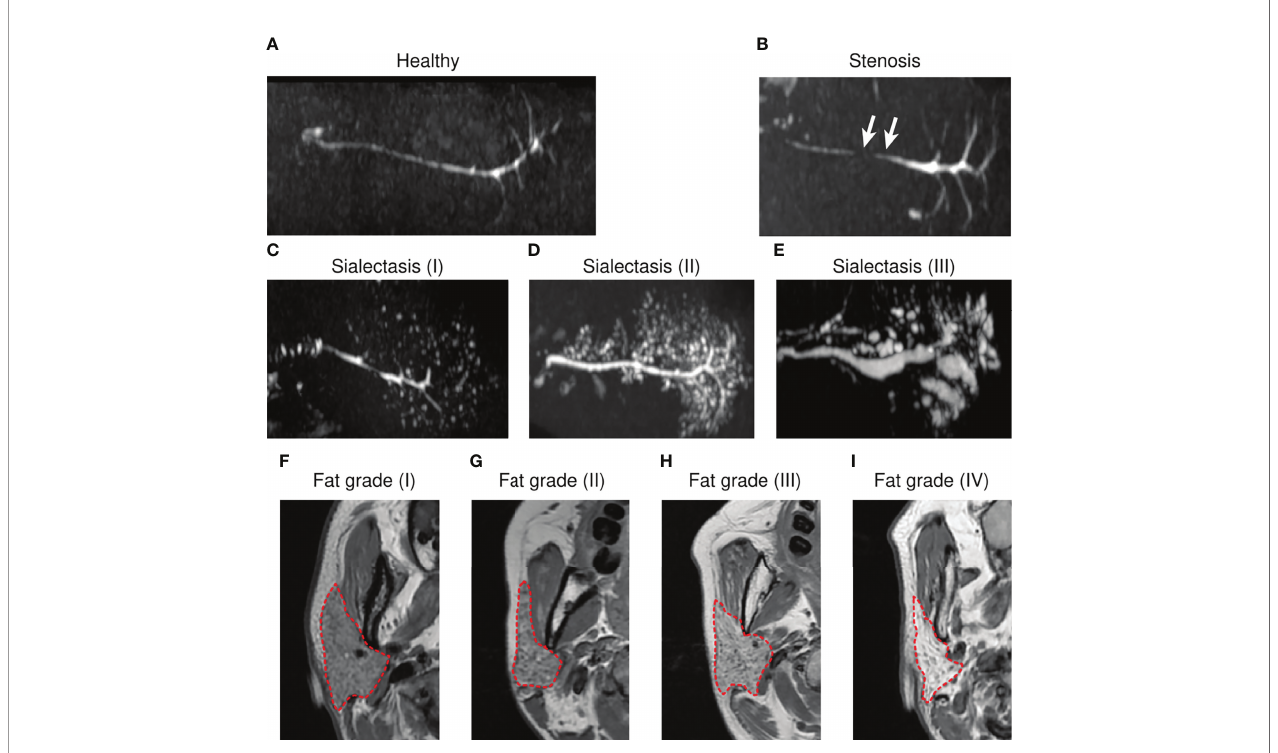
FIGURE 1 | Representative magnetic resonance (MR) sialography images and grading system for fat deposition in the parotid glands. MR sialography images of healthy (A) , stenosis (B) , or sialectasis (C – E) ductal types. White arrows indicate narrowing of the salivary gland duct. For sialectasis, grades are represented in parentheses. (F – I) Characteristic appearances of fat signals on T1 weighted images (T1WIs). (F) Grade 1, normal parotid gland or sparse distribution of streaks-like fat signals. (G) Grade 2, diffusive distributed, honeycomb-like fat signals. (H) Grade 3, less than 50% of the total area of the whole parotid gland. (I) Grade 4, massively homogeneously distributed fat signal. Red dashed oulines indicate fat regions of T1WIs and were considered in fat